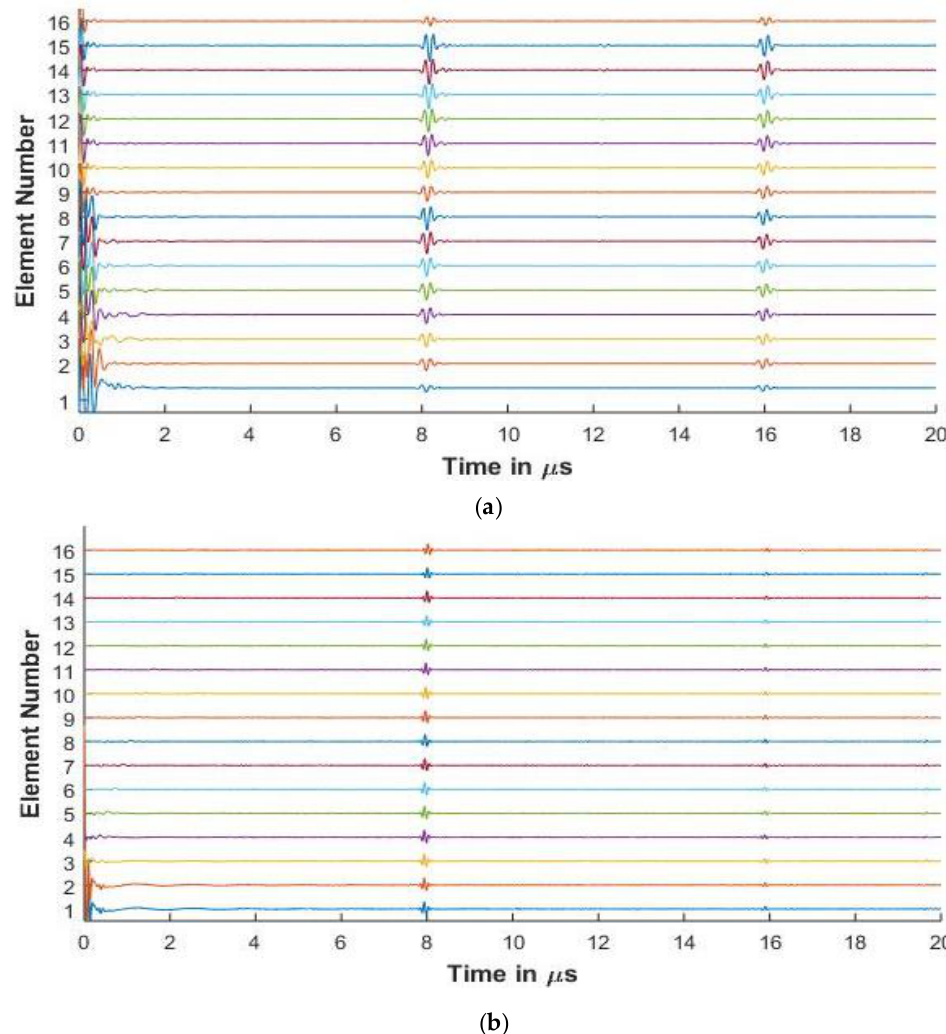
Figure 7. ( a ) Experimental FMC signals obtained for aluminum with 5 MHz 16 element array ( b ) Simulated FMC signals for aluminum with 5 MHz 16 element array.